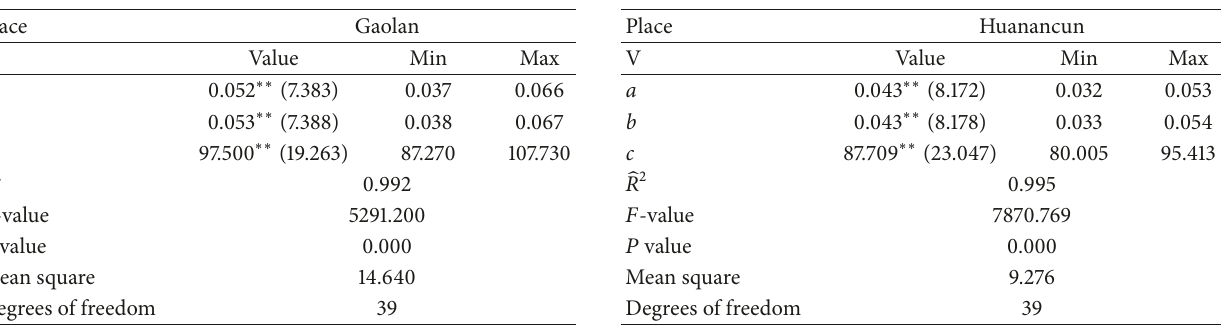
Table 8: Fitting parameters of empirical model on G-7 by laser diffraction technique.